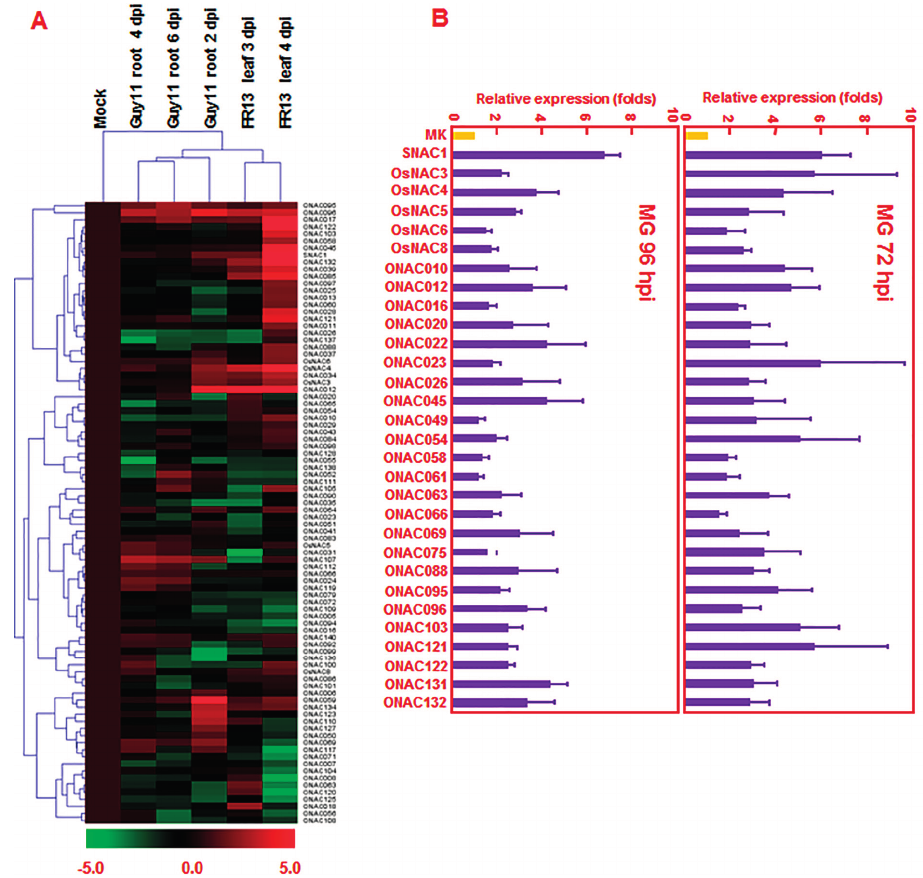
Figure 3. Differential expression of ONAC genes in response to infection by M. oryzae. ( A ) Heat map of ONAC genes showing differential expression patterns after leaf and